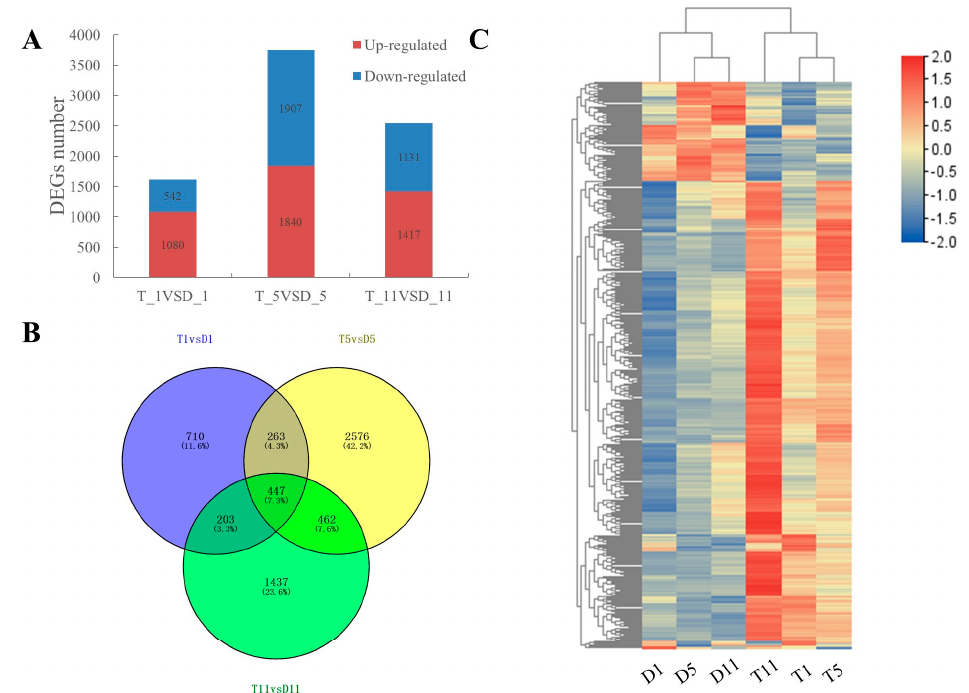
Figure 2. Analysis of transcriptome sequencing data for leaves of diploid and tetraploid poplar